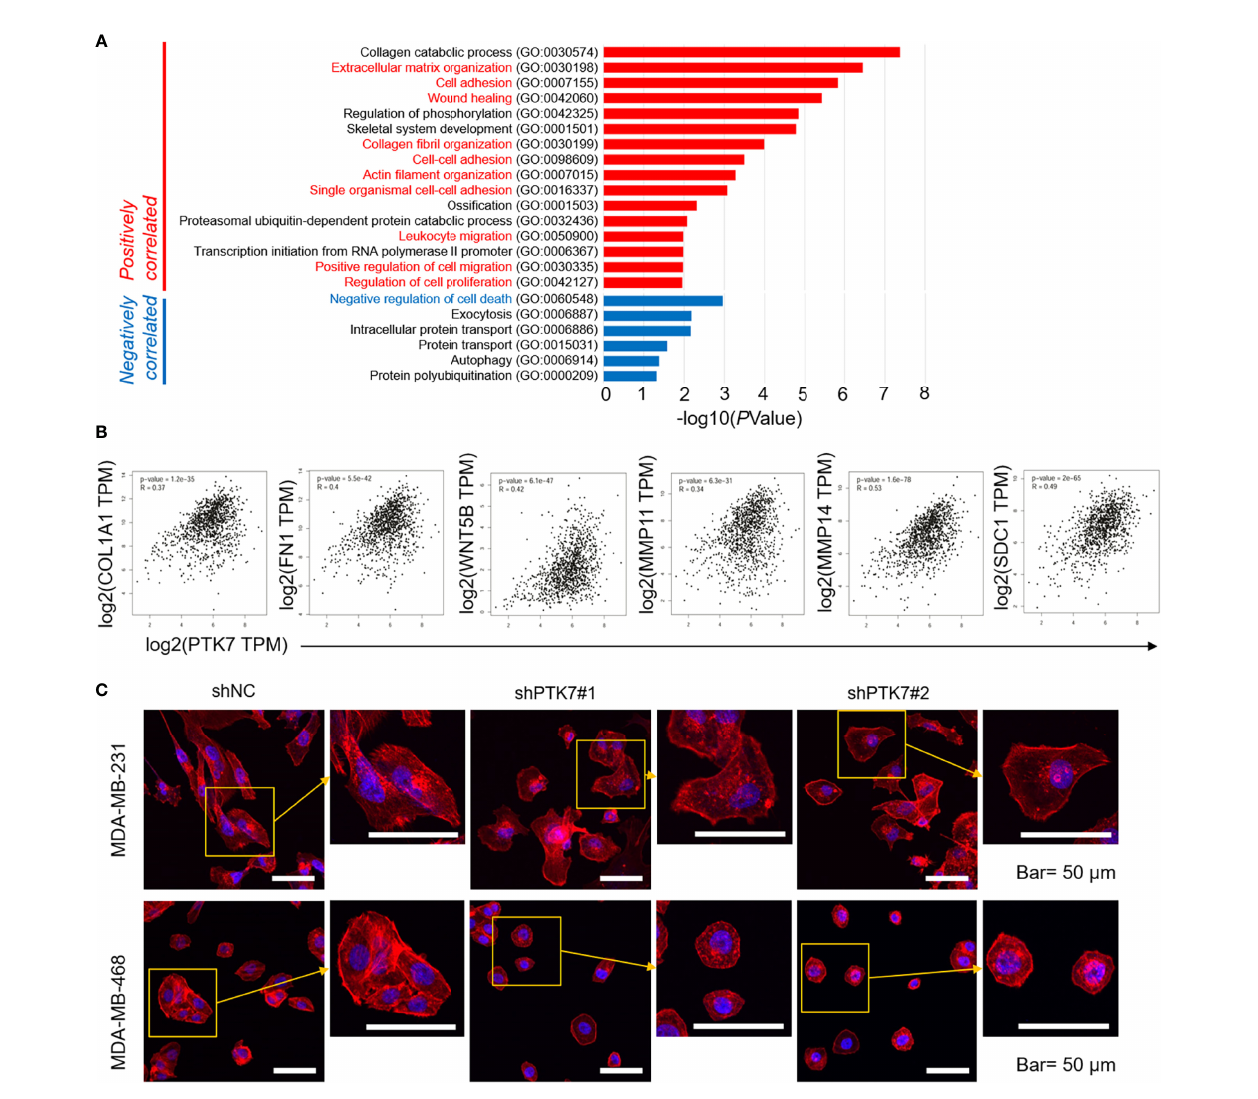
FIGURE 5 | PTK7 associates with extracellular matrix organization and migration in breast cancer cells. (A) Gene Ontology (GO) was performed using DAVID: Functional Annotation Tools (https://david.ncifcrf.gov/tools.jsp) and Biological Process (BP) of PTK7 positively- and negatively-correlated genes were shown. (B) Pair- wise gene correlation of PTK7 with COL1A1, FN1, WNT5B, MMP11, MMP14 or SDC1 in breast invasive carcinoma were analyzed using GEPIA Correlation Analysis tools (http://gepia.cancer-pku.cn/detail.php?clicktag=correlation). (C) MDA-MB-231 and MDA-MB-468 cells were transduced with shNC, shPTK71 or shPTK72. Cells were stained for F-actin with TRITC-phalloidin. Pictures show the TRITC-tagged Phalloidin (red) and DAPI (purple). Presentative images are shown. Magni fi cation, 400×; scale bars, 50 m